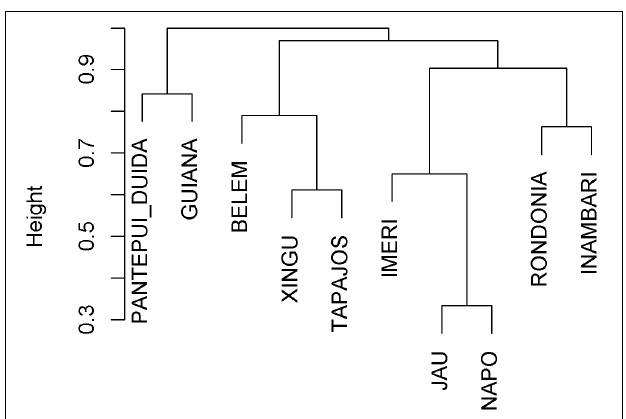
FIGURE 2 | Cluster analysis of the major interfluves in the Brazilian Amazonia based on the primate species composition.